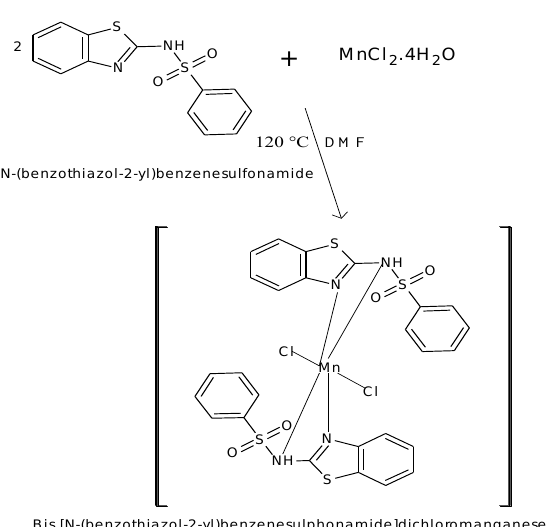
Scheme 3, Synthesis of Mn(II)BS2ABT.